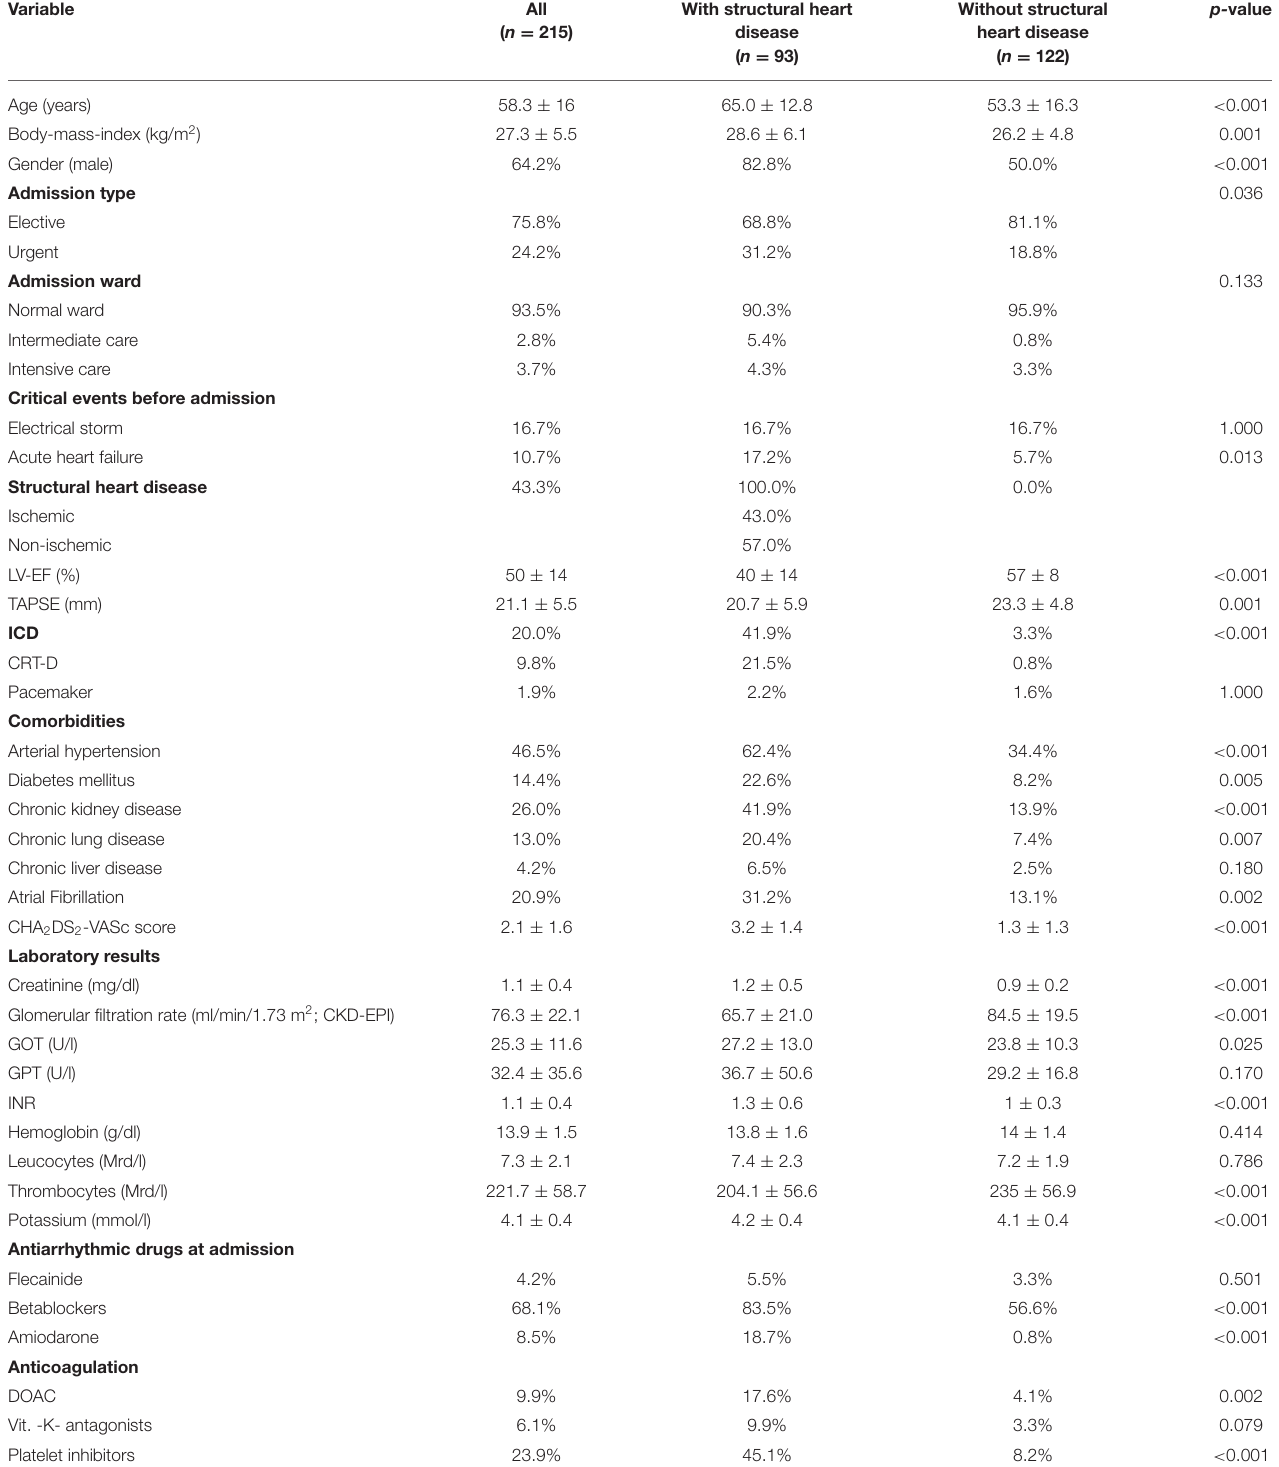
TABLE 1 | Baseline characteristics of patients with outflow tract